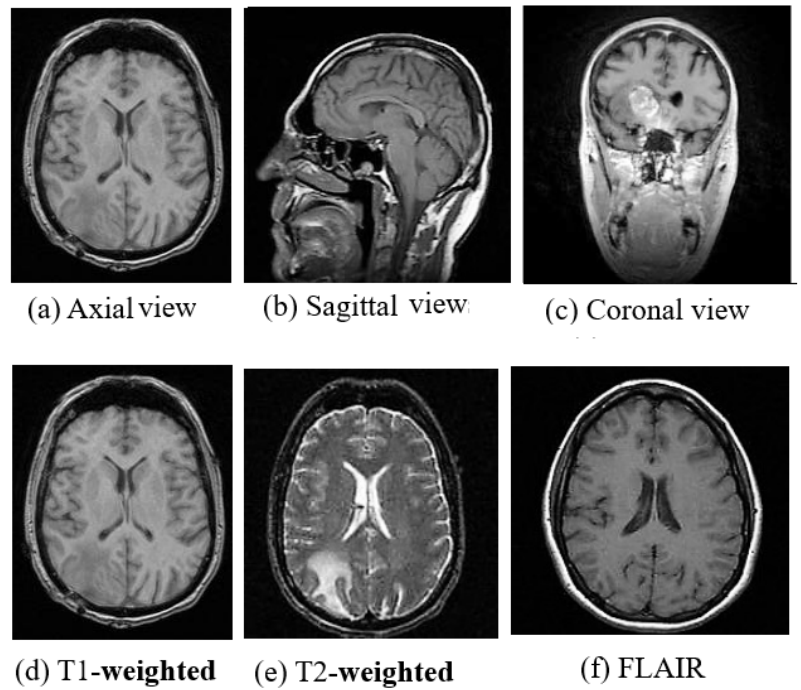
Figure 2. ( a ) Axial view, ( b ) Sagittal view, ( c ) Coronal view and ( d ) T1-weighted, ( e ) T2-weighted and ( f ) FLAIR Images of MRI. (image courtesy: AtheroPoint TM ).